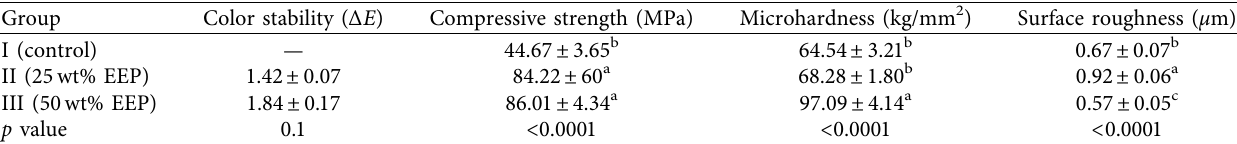
Table 1: Means and standard deviations of the physicomechanical properties of Amalgomer CR incorporated with EEP and Tukey’s